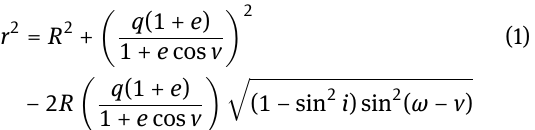
and 300 hyperbolic comets relatively to 100 meteor streams from IAU Meteor Data